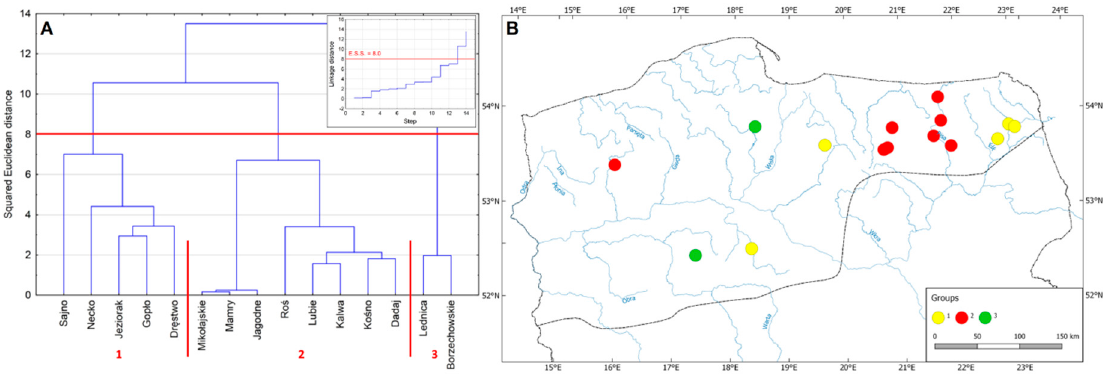
Figure 6. Dendrogram of grouping lakes by values of correlation coefficients of monthly EA indices with monthly water levels and the plot of the linkage distance ( A ); Spatial distribution of lakes in the performed grouping ( B ).